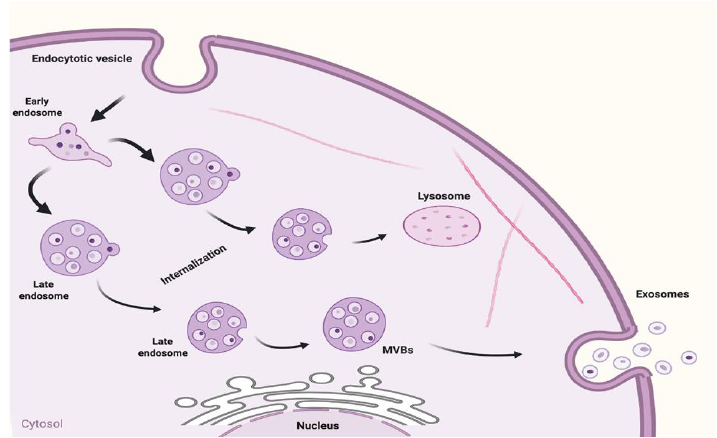
Figure 1. Biogenesis of exosomes.